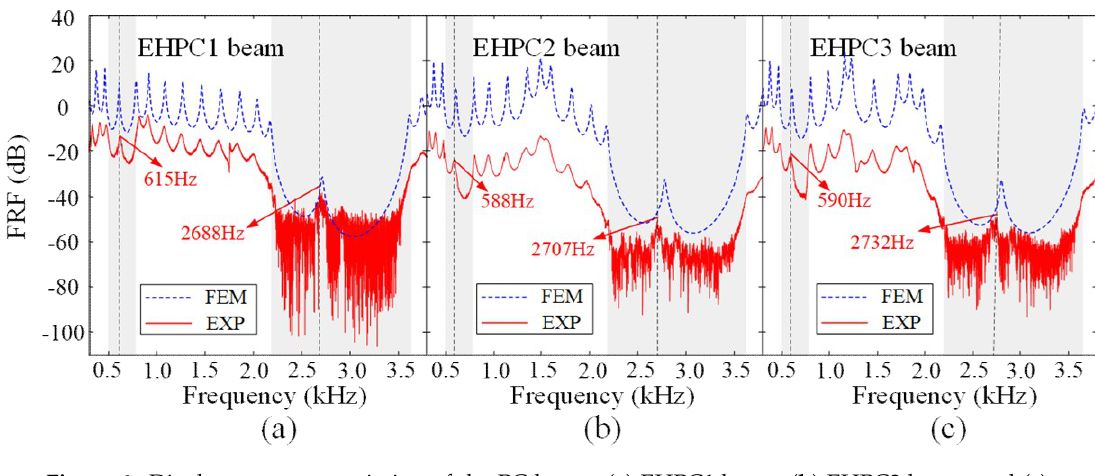
Figure 6. Displacement transmission of the PC beam: ( a ) EHPC1 beam, ( b ) EHPC2 beam, and ( c ) EHPC3 beam (color online). Table 1. Comparisons of the band gaps and defect modes obtained by the finite element method (FEM) and fiber Bragg grating (FBG) 1